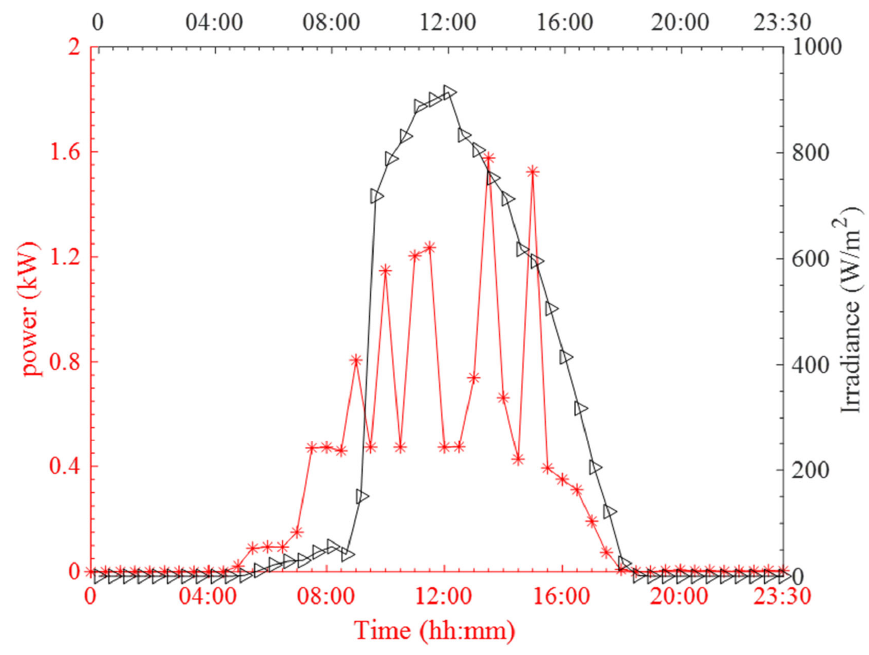
Figure 7. Average weekday profiles of power consumed and global irradiance. (kW denotes kilo Watt , W/m 2 represents Watt per meter square, hh denotes hour and mm denotes minute).